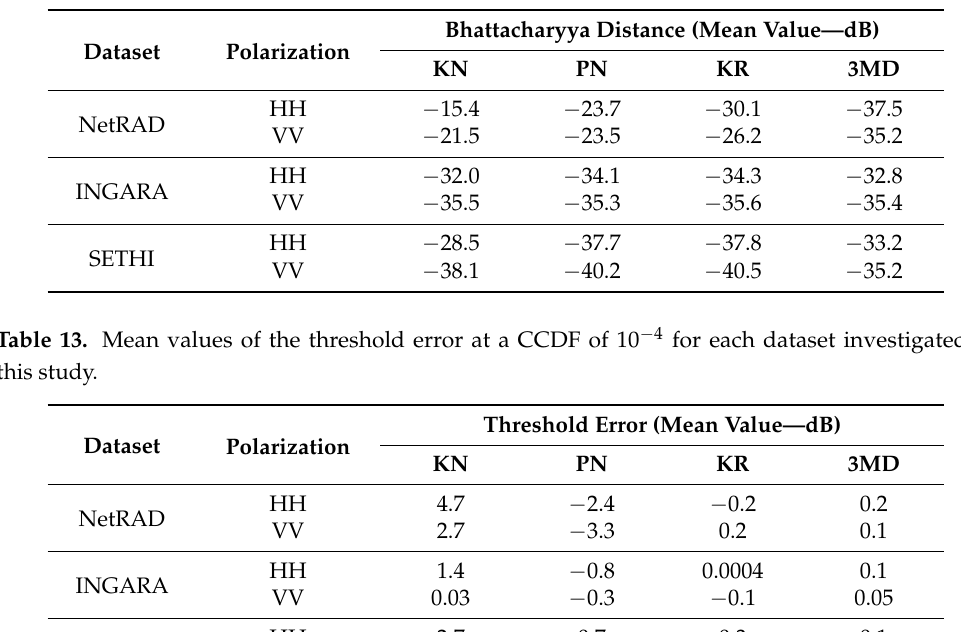
Table 12. Mean values of the Bhattacharyya distance for each dataset investigated in this study.